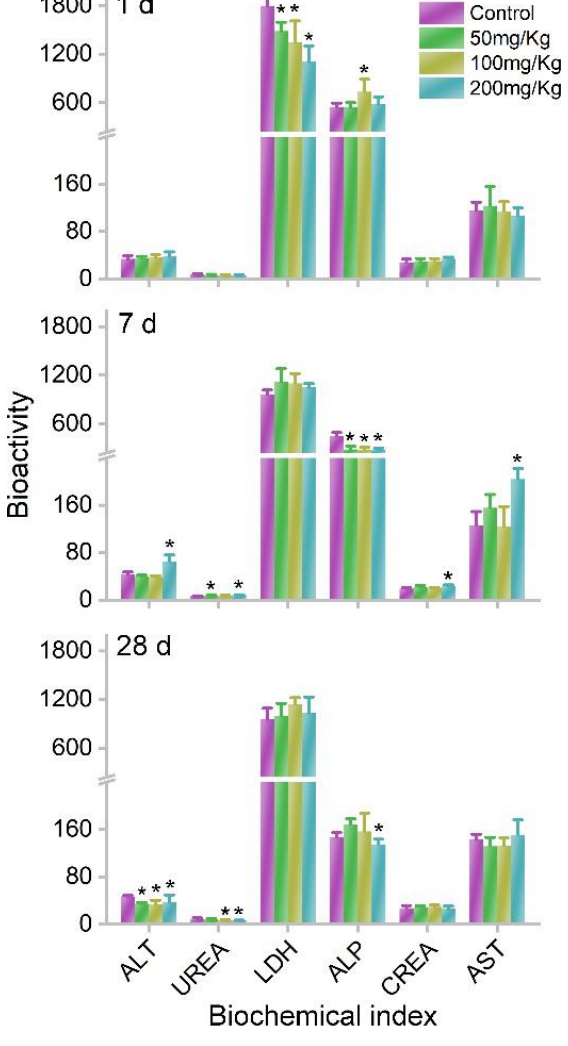
Figure 4. Serum biochemistry of mice after exposure to MOF-74(Co) ( n = 4). * p < 0.05 compared to the control group.